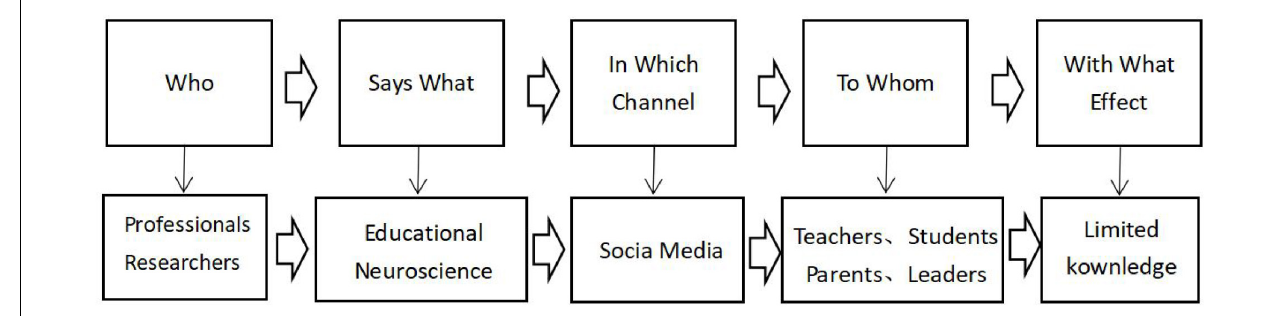
FIGURE 3 | EN knowledge dissemination based on Lasswell’s 5W